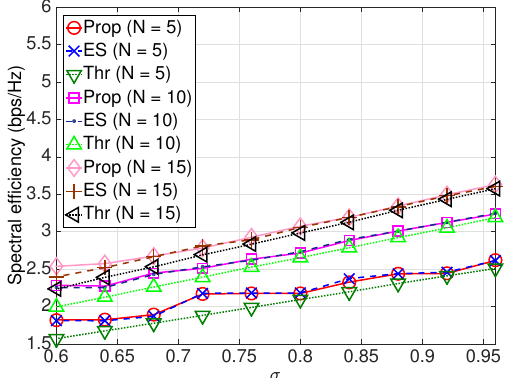
Figure 7. Spectral efficiency vs. σ by varying N .